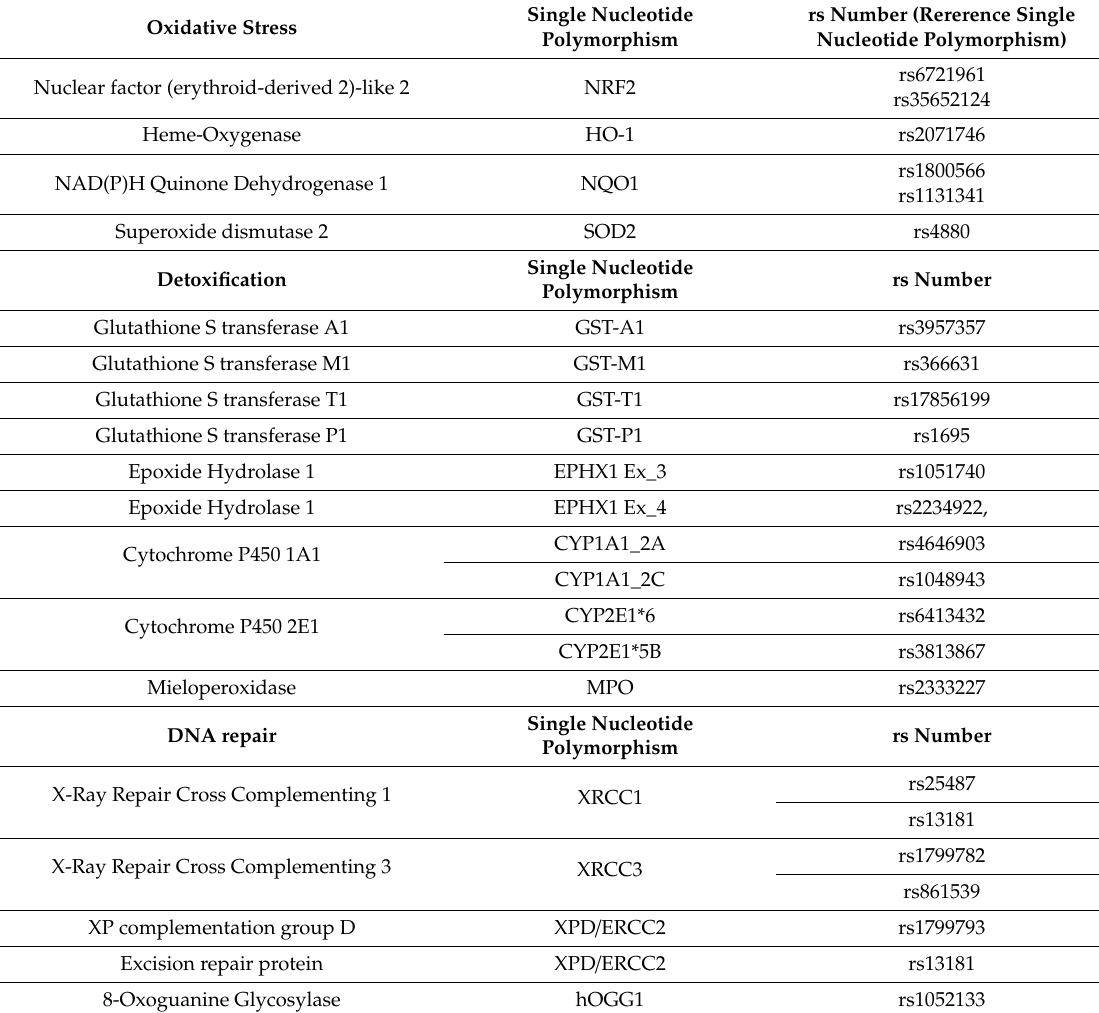
Table 1. List of gene polymorphisms, grouped by functional activity and analyzed by principal component analysis